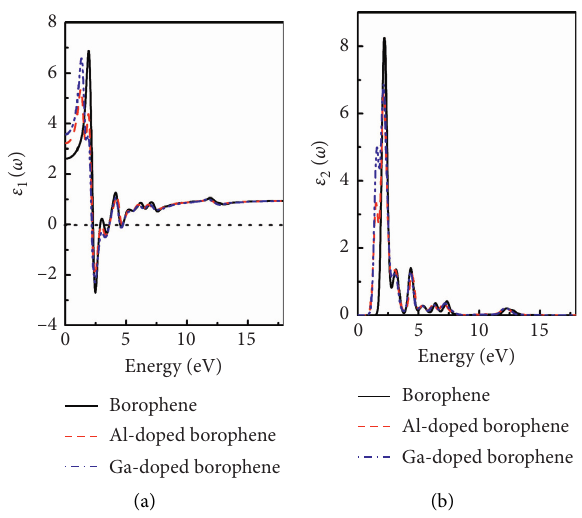
Figure 5: Complex dielectric functions of borophene. (a) ε